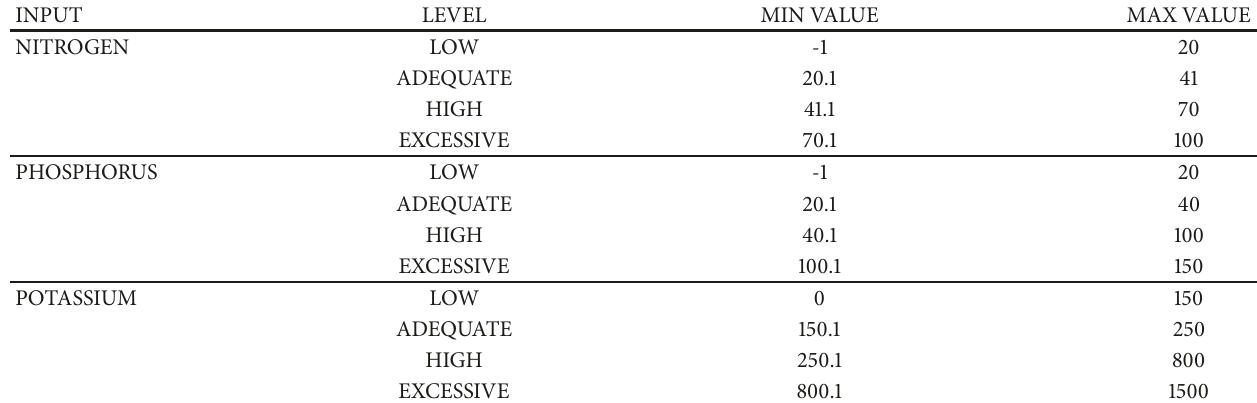
Table 1: Input variables with their linguistic functions showing minimum & maximum values.